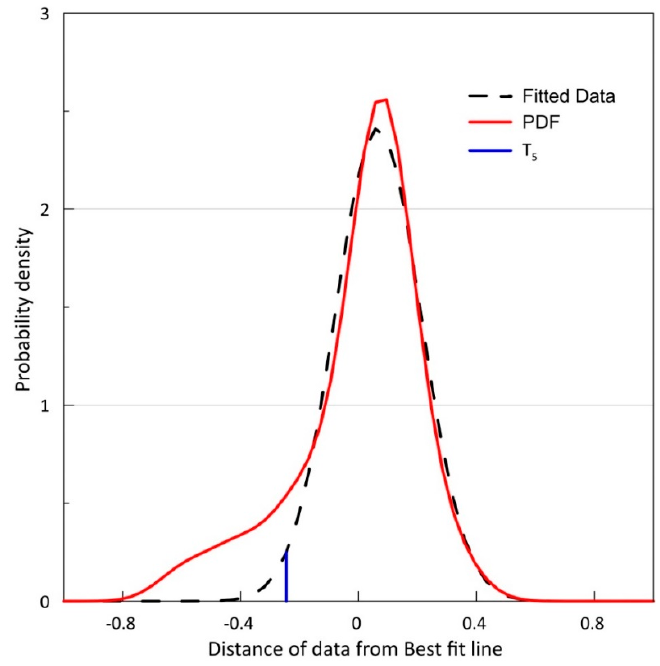
Figure 4. Probability density function of δ E distribution.